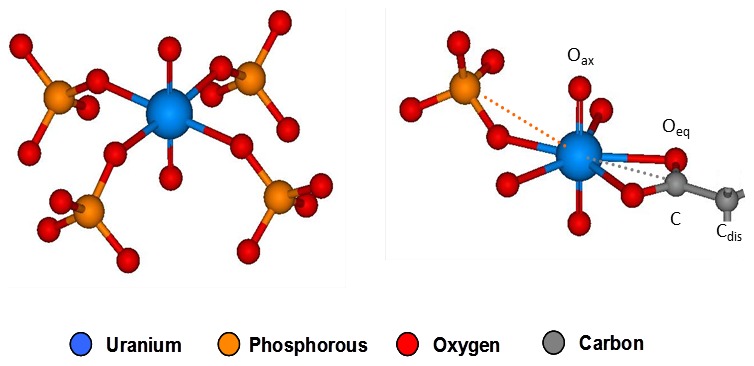
Structural models used for the fitting procedure of the EXAFS spectra obtained from the uranium complexes build by the cells of Paenibacillus sp. JG-TB8.The left model created from the crystall structure of meta-autunite was used for the fitting procedure of the sample incubated at pH 6 under oxic conditions. The right model contains fragments of meta-autunite (monodentate coordination at phosphate groups) as well as uranyl triacetate (bidentate coordination to carboxylic groups) and was used for the fitting procedures of all other samples.